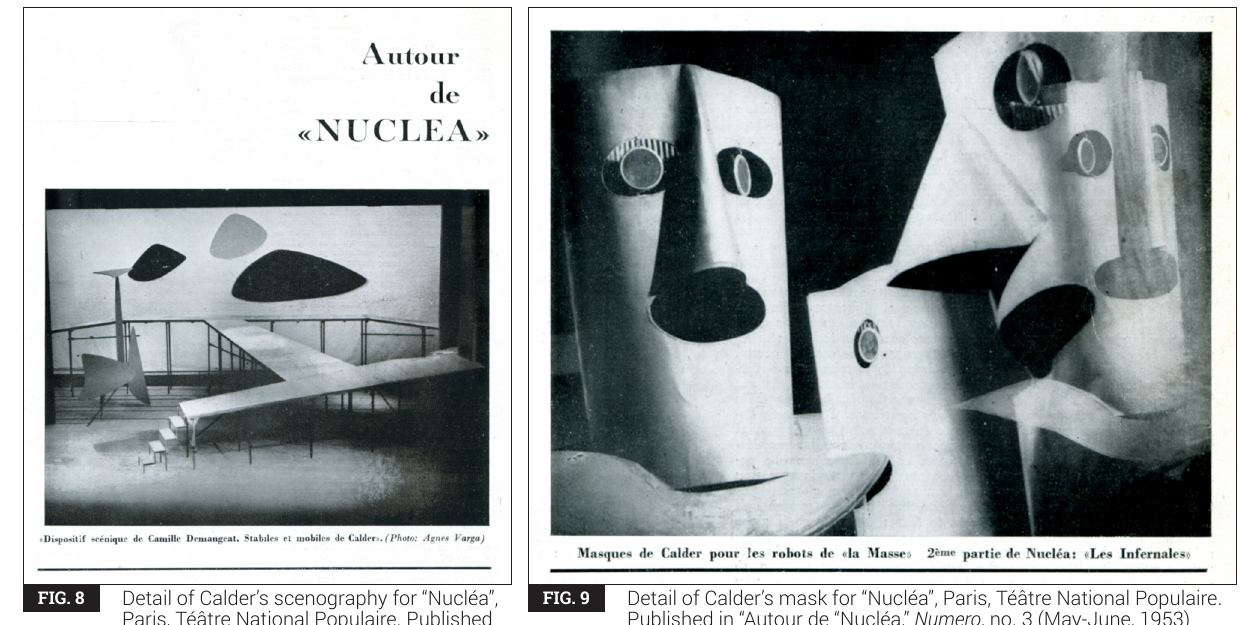
Detail of Calder’s mask for “Nucléa”, Paris, Téâtre National Populaire. Published in “Autour de “Nucléa,” Numero , no. 3 (May-June, 1953)